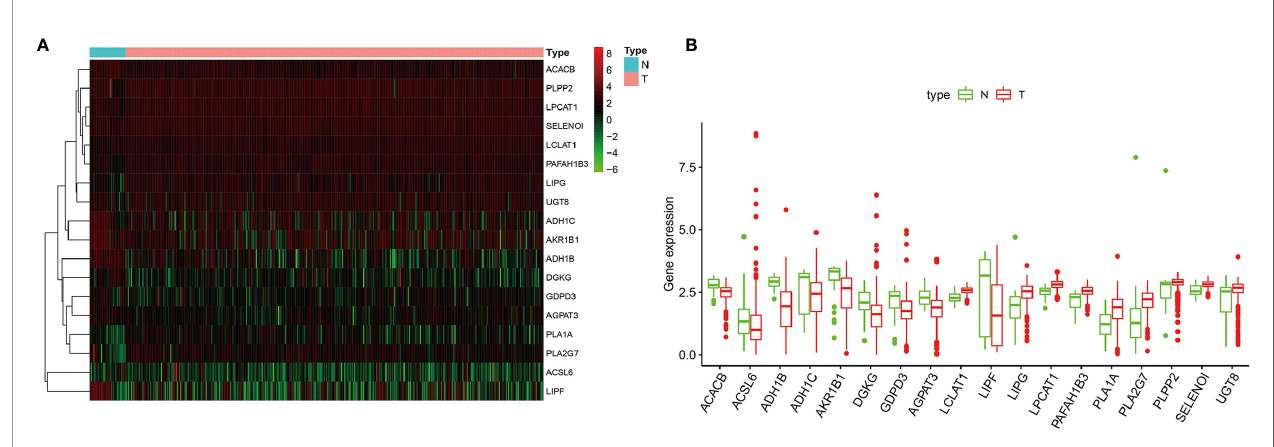
FIGURE 2 | (A) The heatmap of differentially expressed genes (DEGs) between gastric cancer (GC) and normal tissues. (B) Boxplots of mRNA expression of